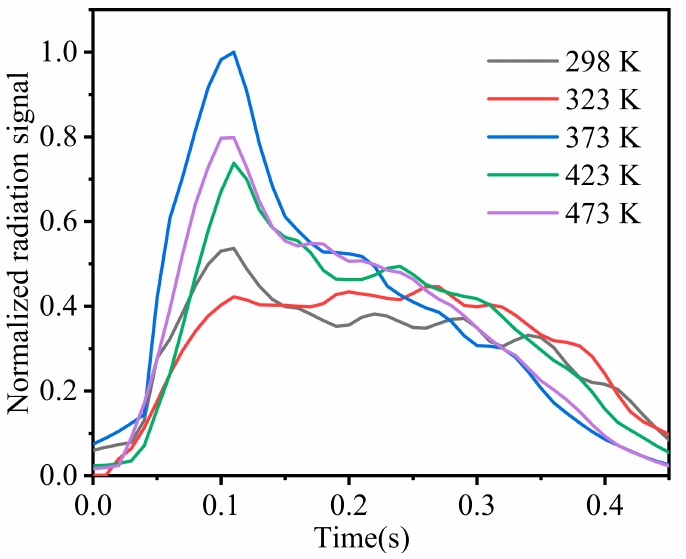
Figure 9. Variation in average thermal radiation signal in the flame with